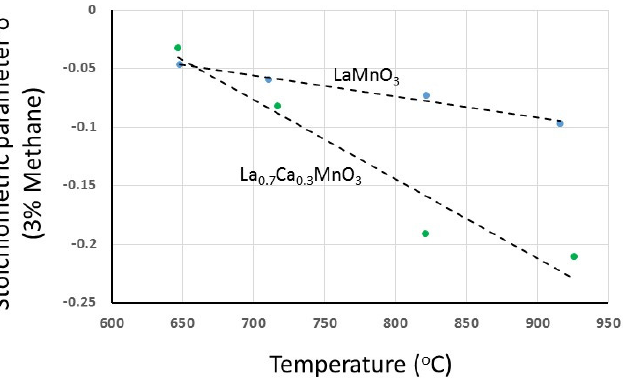
Figure 8. The dependence of oxygen deficiency (at 3% methane) on temperature for LaMnO 3 and La 0.7 Ca 0.3 MnO 3.